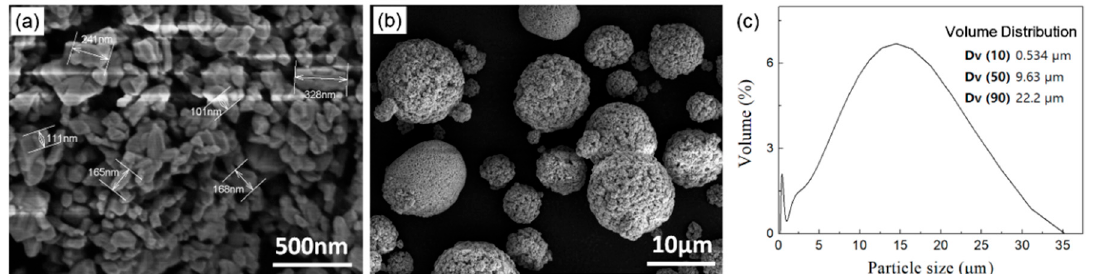
Figure 1. The SEM images of the ( a ) initial and ( b ) agglomerated GDC powder, ( c ) the particle size distribution of the agglomerated GDC powder.